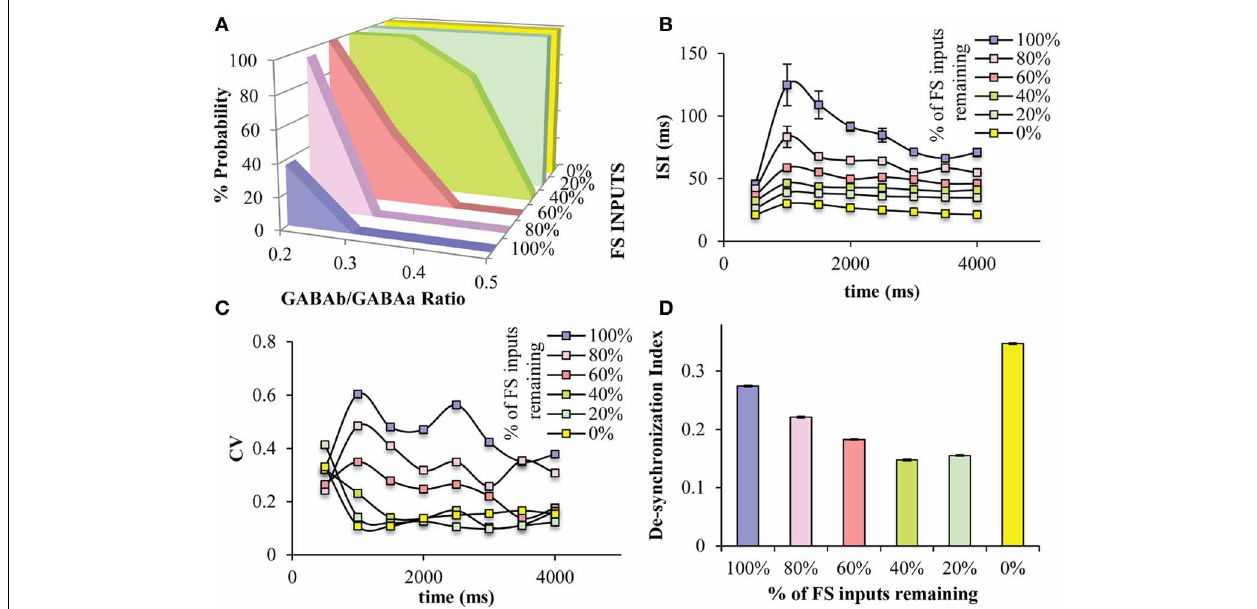
decreases, the ISIs of the pyramidal neuron model decreases. (C) As the number of the FS inputs decreases, the CV of the ISIs of the pyramidal neuron model decreases. (D) The synchronicity among all neuron models during persistent activity, is significantly reduced when no PV inputs are present in the microcircuit, while it increases by decreasing the number of synaptic inputs from the FS model neurons to the pyramidal model